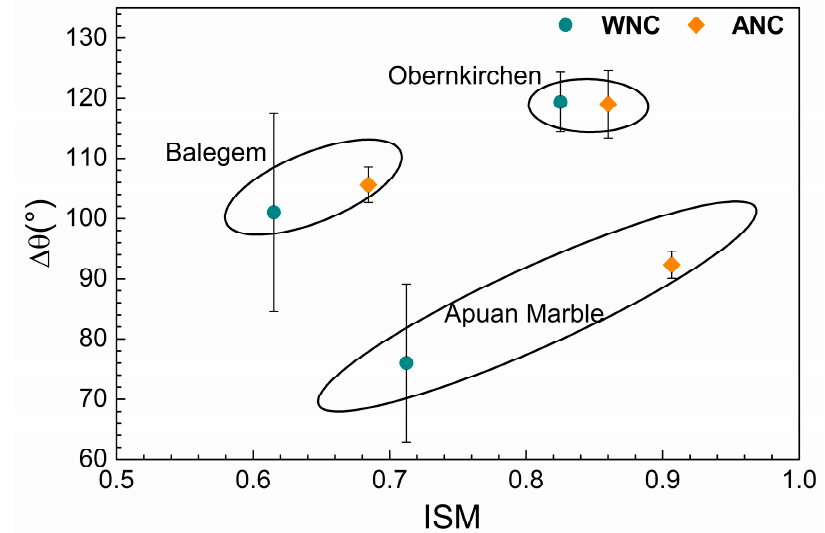
Figure 6. Correlation between the index of surface modification (ISM, Equation (3)) and Δθ (see Section 2.4.3) for lithotypes after treatment with WNC/ANC.